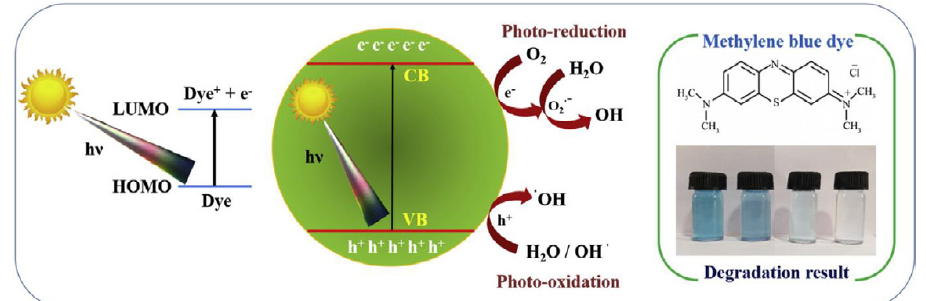
Fig. 8. Mechanism for the dye degradation using cow urine mediated Ag